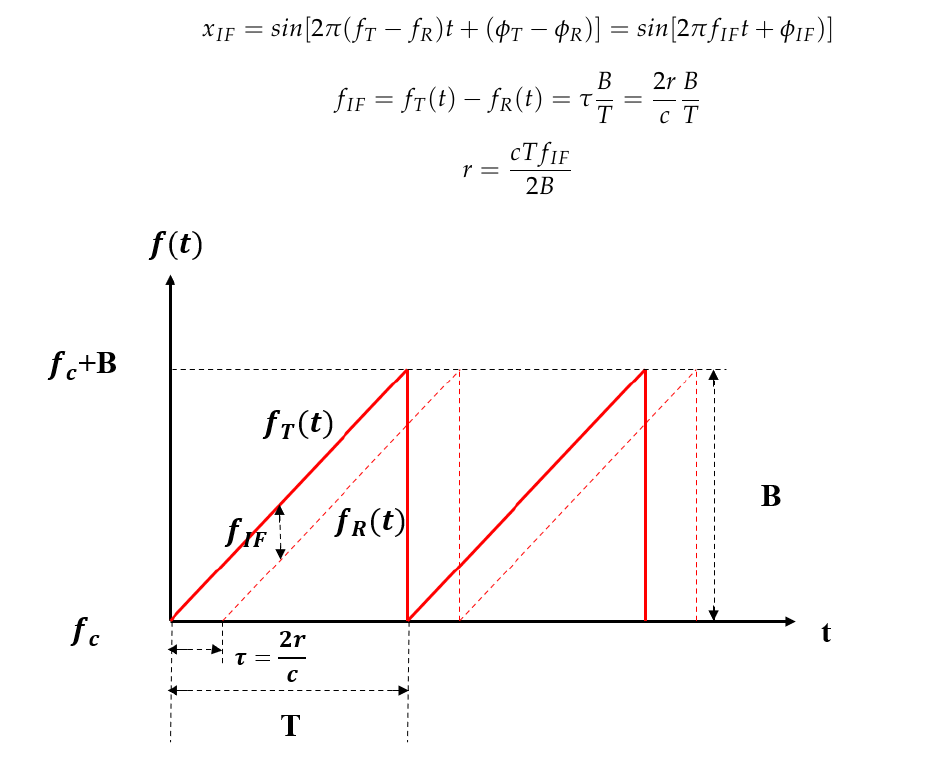
Figure 1. The chirps of FMCW mm-wave